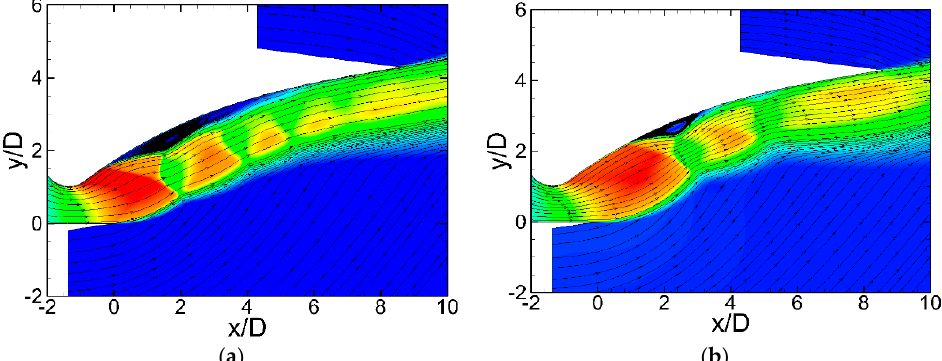
Figure 5. Typical velocity contours and streamlines at p 0 = 7 bar, T 0 = 436 K. ( a ) Dry airflow; and ( b ) the wet-steam flow.